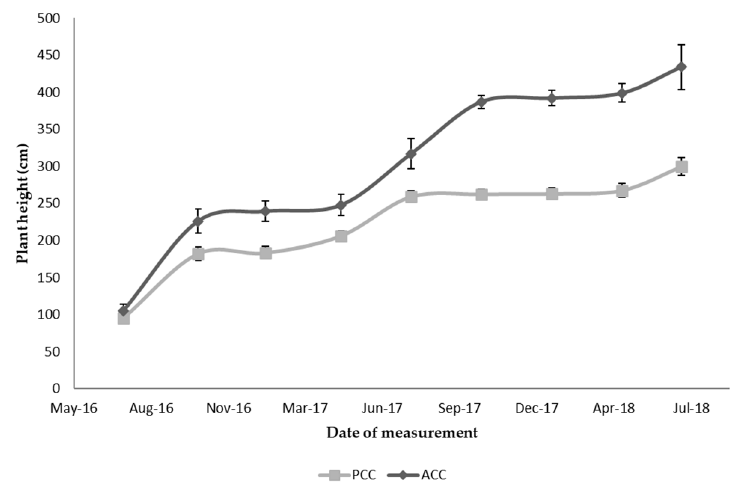
Figure 3. Plant height changes in “Siluet” papayas grown in passive climate control (PCC) and active climate control (ACC) modules. Symbols represent the mean values of plant height while bars represent the standard deviations.